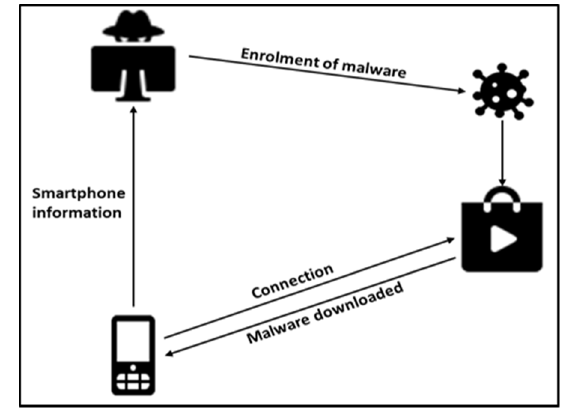
Fig. 1: Malware Attack Scenario, adapted from [11] Usually, an attacker registers a loaded altered malicious application, which is available free of charge at the black market, and puts up the file APK (Android Package Kit) onto the famous Blogs and Social networking sites to make it possible for many people to install the altered malicious application (see, Fig. 1). As soon as users download that malicious application, their phone gets infected by the malware, and they lose control of their device